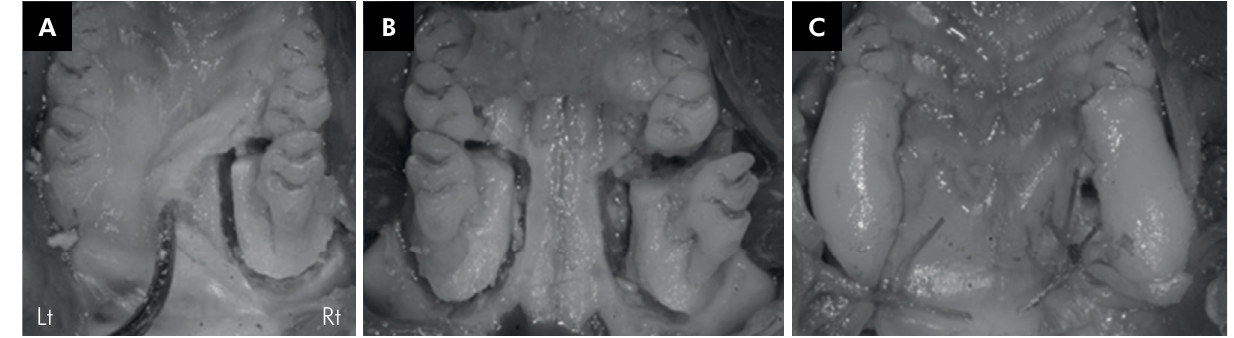
Figure 1. Design of the alveolar segmental osteotomy. A) After a mucoperiosteal flap was elevated on the first maxillary molar, the alveolar segmental osteotomy was performed. B) The bony segment of the experimental group was buccally displaced (right), while the control group was not displaced (left). C) After the flap was sutured, the bony segments were fixed with a light-curing glass ionomer (GI)